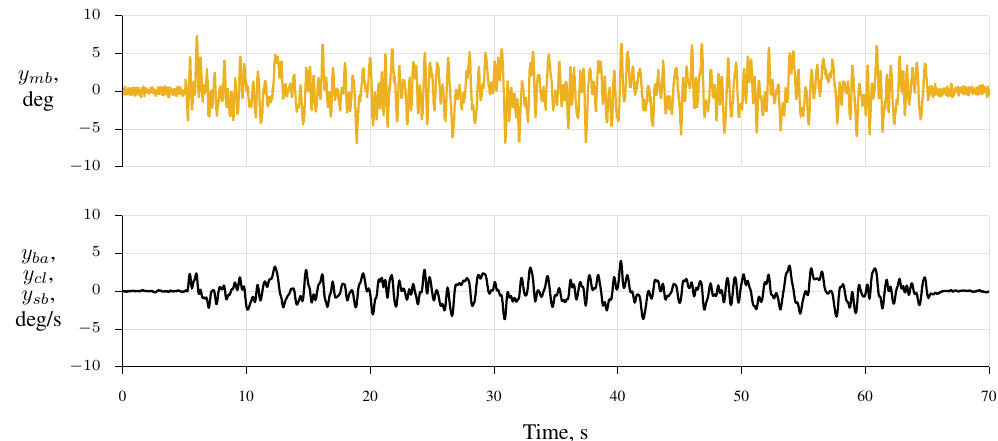
Figure 10. The X-59 loop output time